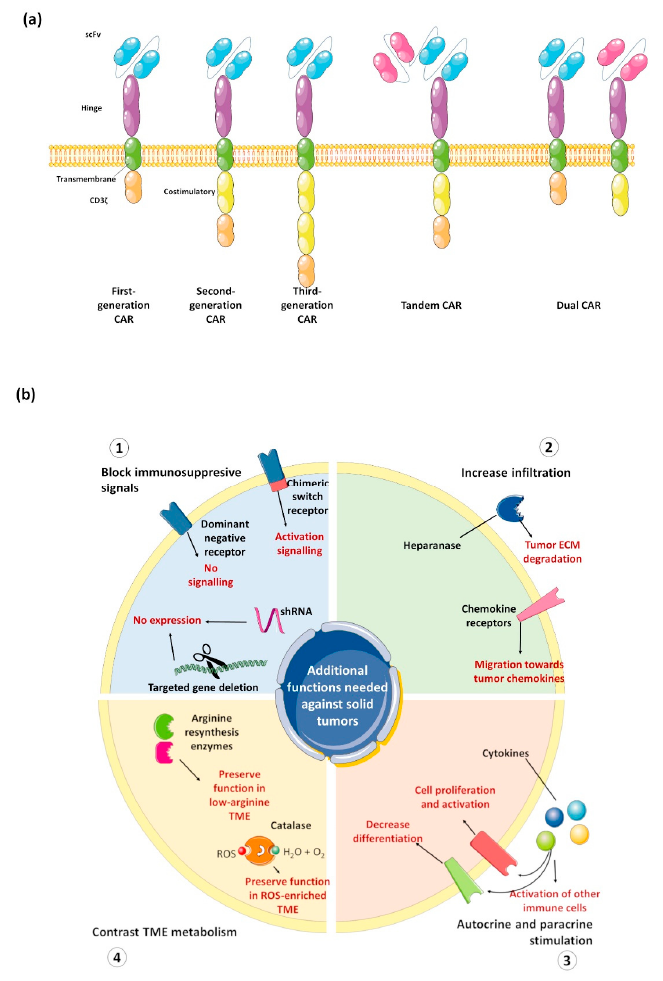
Figure 2. CAR designs against solid tumors. ( a ) Typical design of most common CAR constructs, from historical first-generation CAR construct to constructs simultaneously targeting two targets; ( b ) schematic representation of major strategies explored to overcome resistance of solid tumor to CAR-based therapies. The Figure was partly generated using Servier Medical Art, provided by